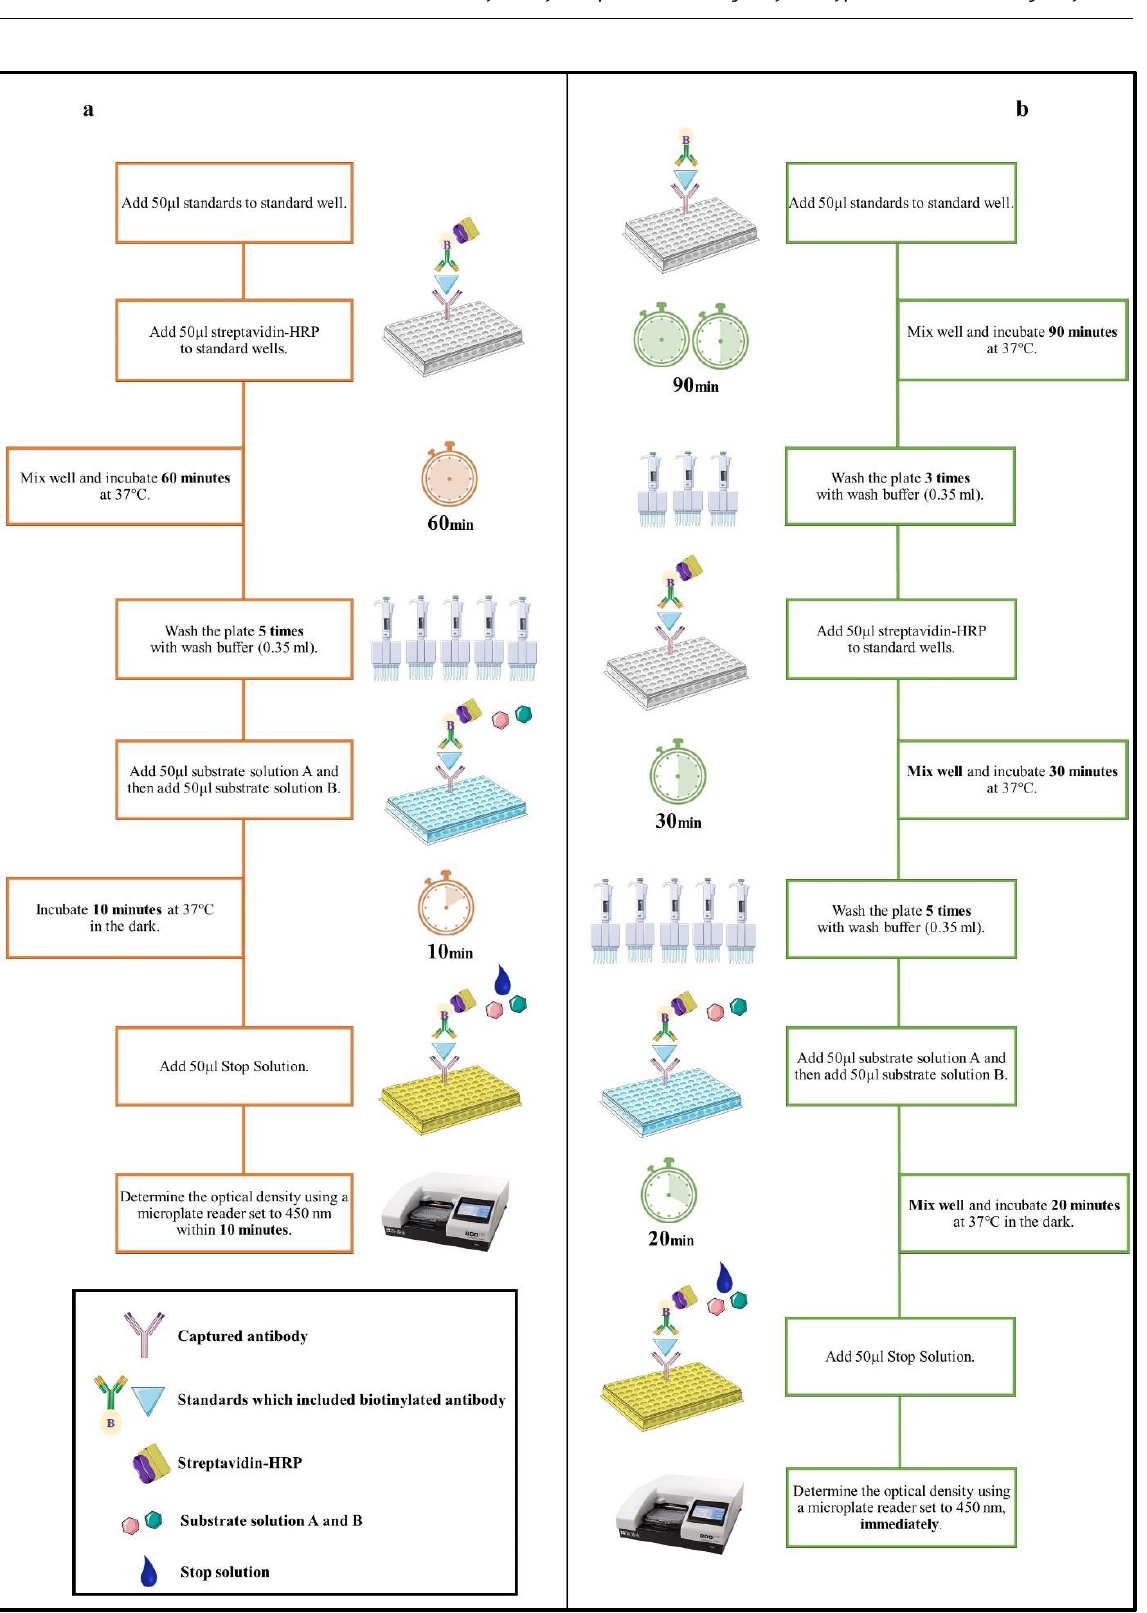
Figure 1: Flowchart of original BT human TMAO ELISA kit protocol ( a ) and modified BT Human TMAO ELISA kit protocol ( b ). The figure has been prepared using the Servier Medical Art website